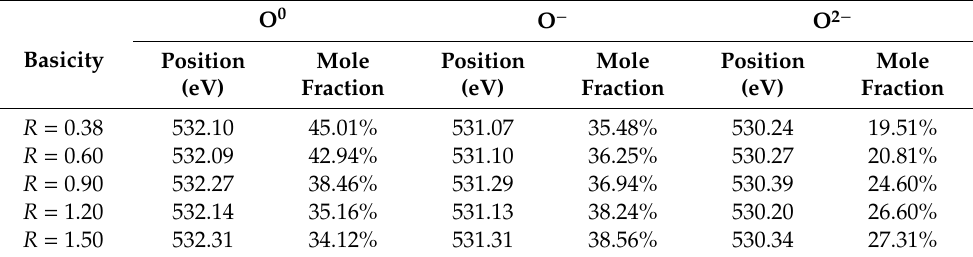
Figure 14. The XPS peak fitting spectrum of O 1s in water quenching slag sample at different basicities: Table 3. Fitting positions and mole fractions of different types of oxygen atoms.